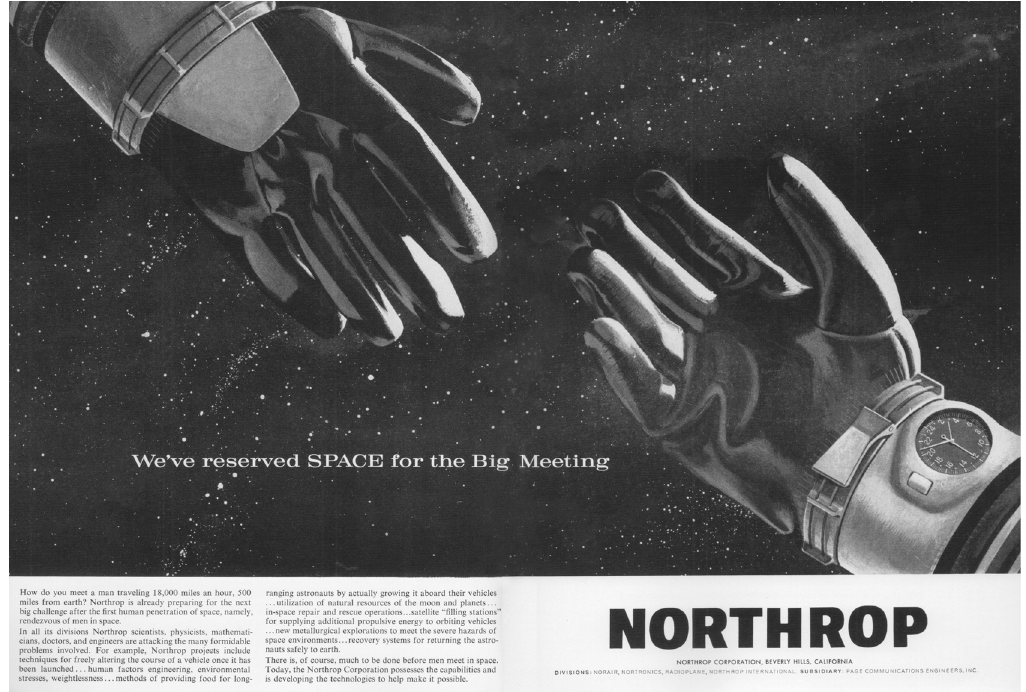
Figure 2. A 1960 advertisement used by Northrop to promote its advanced engineering appropriates Michelango’s Sistine Chapel to illustrate the precision needed to achieve rendezvous in space, a requirement that helped America put a man on the Moon. Missiles and Rockets , May 23,